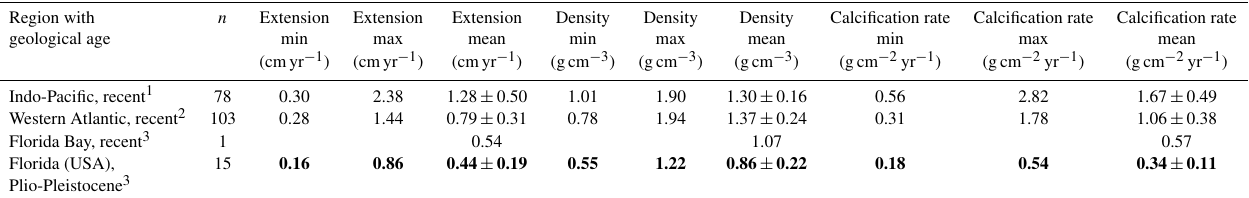
Table 3. Bulk calcification data of recent reef corals in the Indo-Pacific and Western Atlantic together with fossil reef corals from Florida (USA). Bold: minimum values. Data sets listing only extension rates not included in this table. Region with n